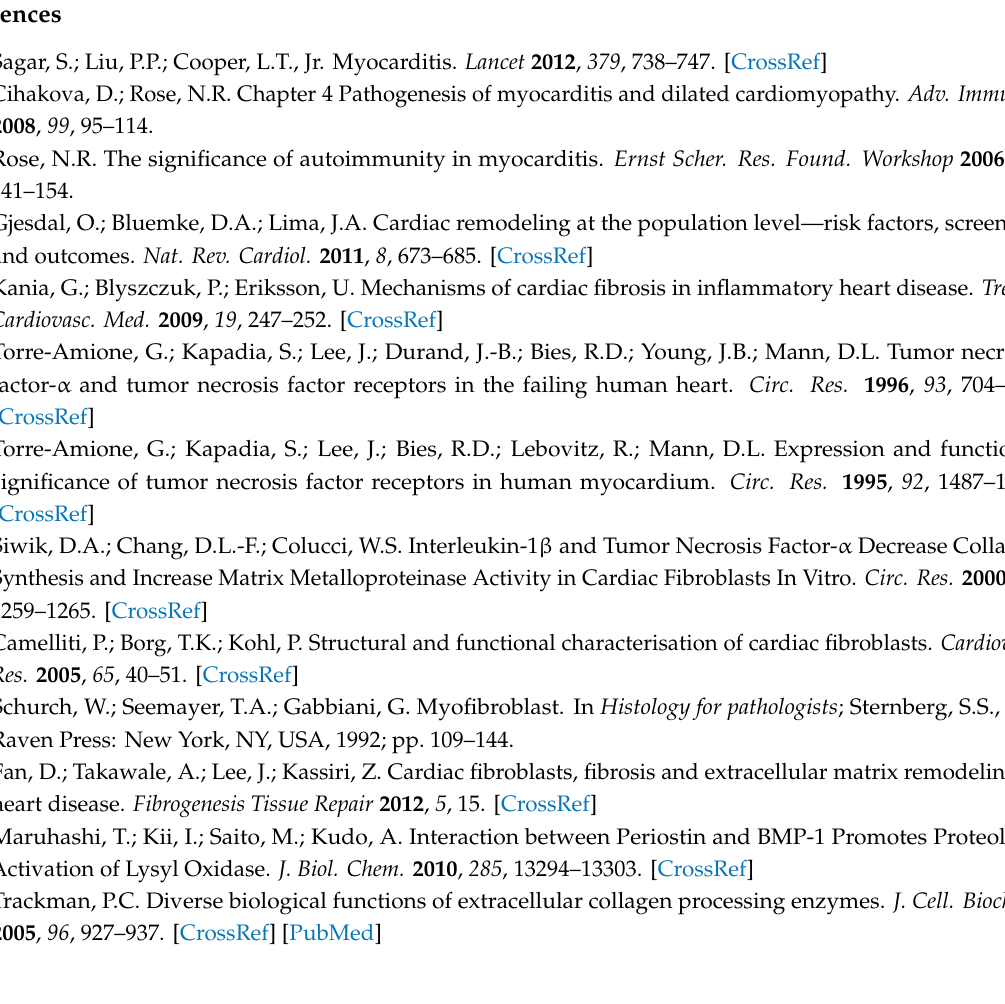
Figure S1: sPLA 2 -IIA modulates cardiac fibroblasts phenotype, Figure S2: E ff ect of the EGFR inhibitor AG1478 on sPLA 2 -IIA-induced ROS accumulation in cardiac fibroblasts, Figure S3: E ff ect of inhibitors that block EGFR transactivation on sPLA 2 -IIA-induced ROS increase in cardiac fibroblasts, Figure S4: E ff ect of selected inhibitors on sPLA 2 -IIA-induced BMP-1 and LOX expression in cardiac